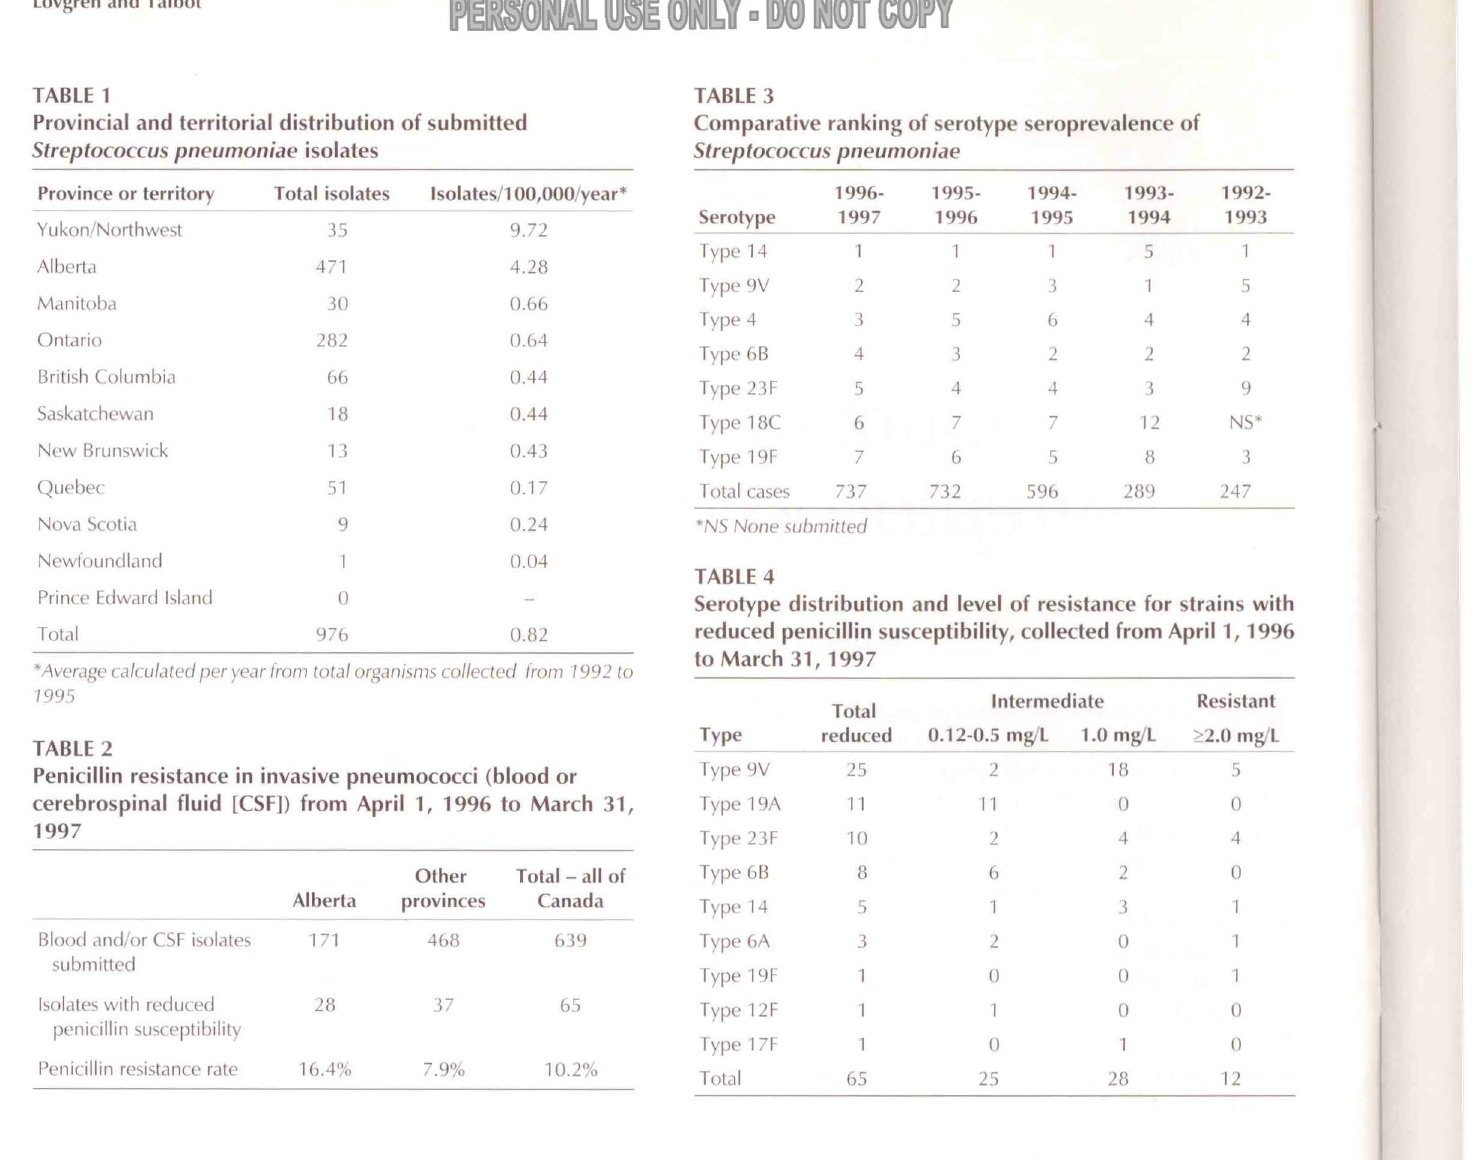
Streptococcus pneumoniae isolates